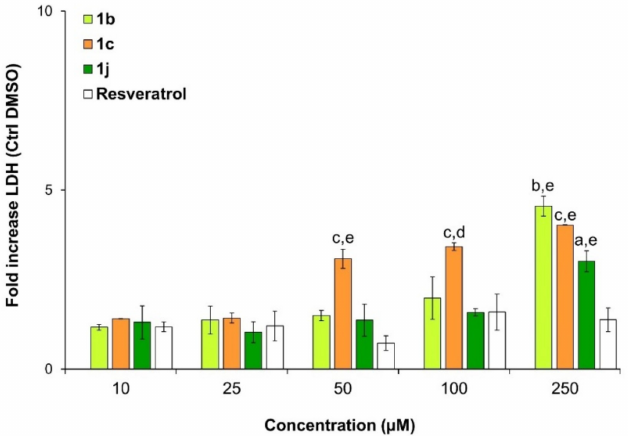
Figure 9. LDH released by MCF7 human breast cancer cells in the presence of increasing concentra- tions of compounds 1b , 1c , 1j , and RSV after 24 h. Data shown are the means ± S.D. of three replicates and are expressed as the fold increase on the LDH released by cultures in the presence of vehicle (DMSO) set as 1 (data not shown). a = p < 0.01; b = p < 0.001; c = p < 0.0001 between compounds and DMSO; d = p < 0.01; e = p < 0.001 between compounds and RSV at the same